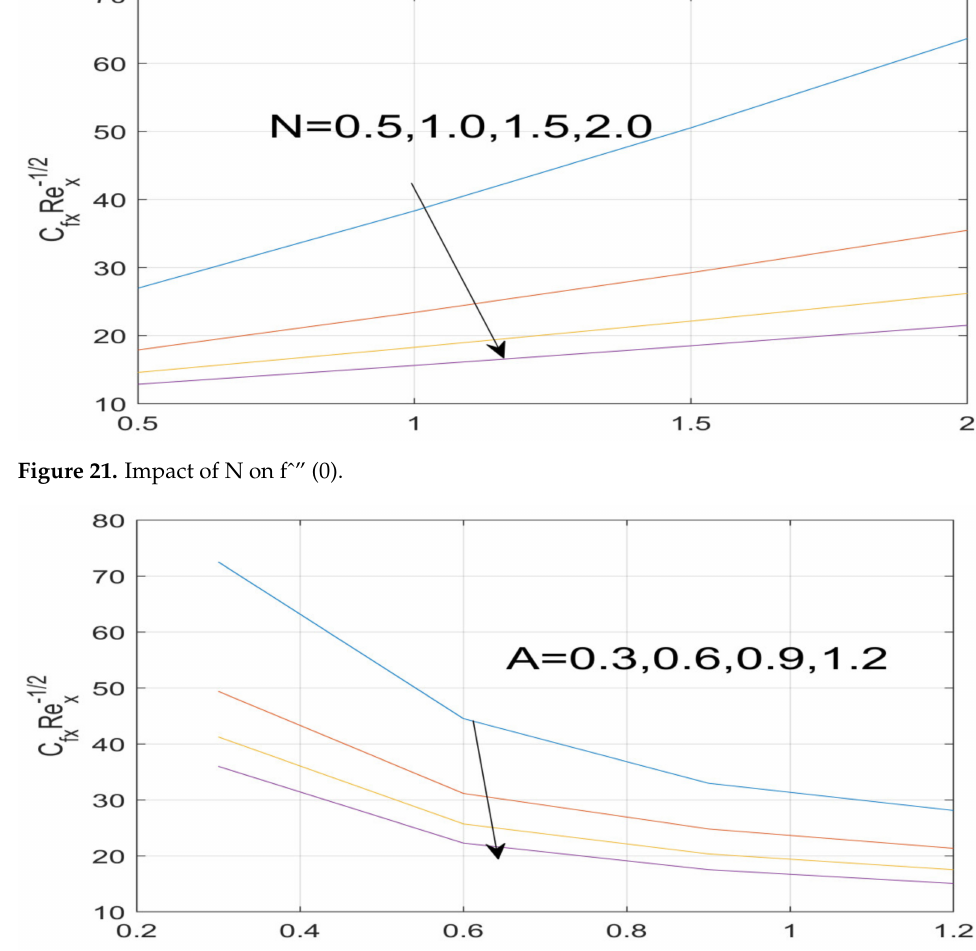
Figure 22. Effect of A on fˆ”